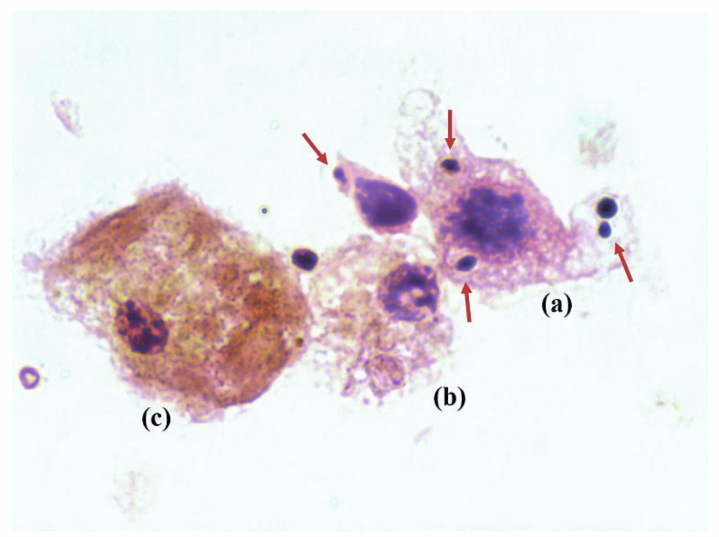
Figure 4. Cytological image of a Gram stain showing a macrophage ( a , b ) phagocytizing multiple yeasts (red arrows), and a myocyte ( c ).